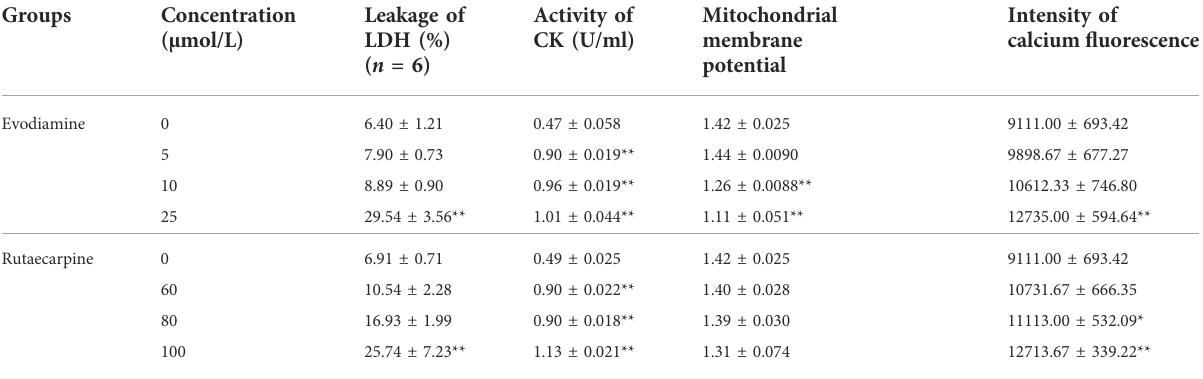
TABLE 2 Cell cytotoxicity assay of evodiamine and rutaecarpine in H9c2 ( n = 4, ‾ x ± s ).